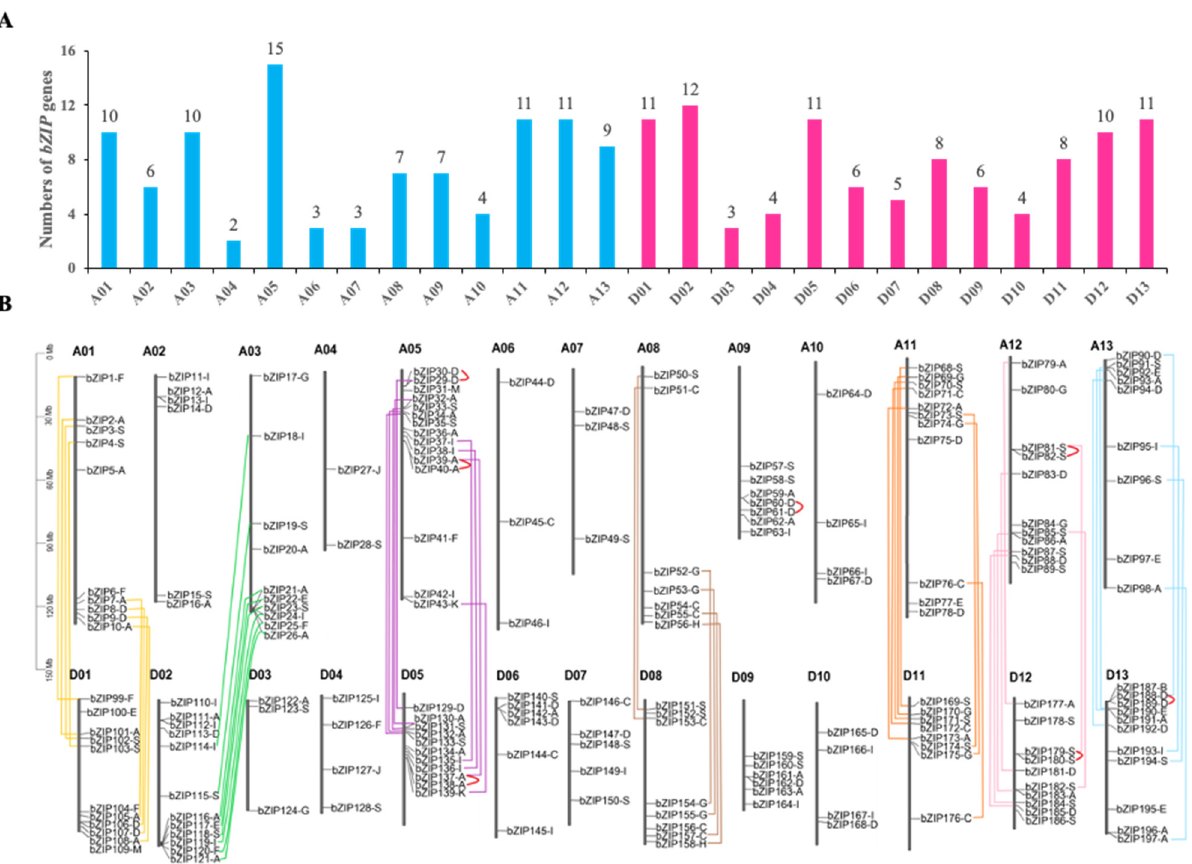
Figure 1. Distribution of 197 GhbZIP genes on cotton chromosomes. ( A ) Distribution of GhbZIP genes on different cotton chromosomes. ( B ) Duplication events of GhbZIPs on cotton chromosomes. GhbZIP genes are numbered 1 to 197. The duplication events of cotton GhbZIP genes are presented in color, of which 7 tandem duplications are expressed in red lines, and the replication of segments on different chromosomes are expressed in other colors.